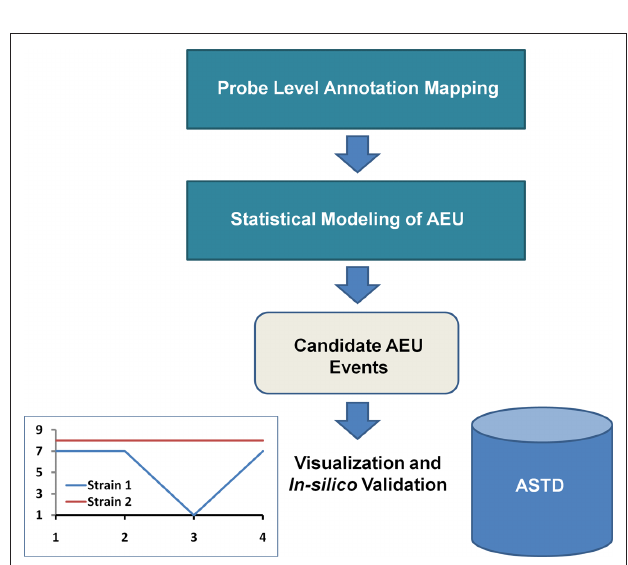
FiguRe 2 | Computational Framework for Aeu Detection. Prior to statistical analysis, the probe level data is mapped to a single transcript annotation. After statistical modeling, putative candidates are identified, which can be visualized via interaction plots and alignment with entries of known AEU/splice events from a source such as the alternative splicing and transcript diversity database (ASTD) 1